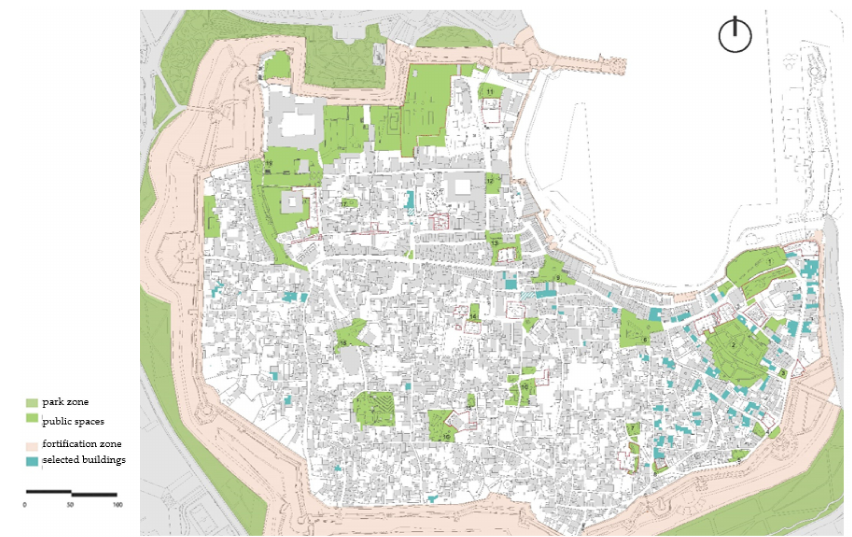
Figure 4. Public spaces and parks of the Medieval